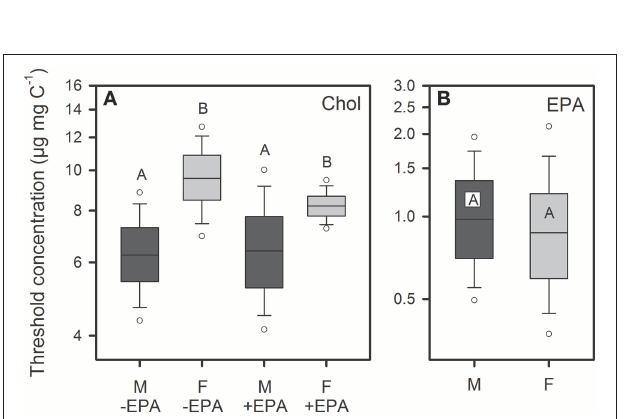
FIGURE 2 | Dietary threshold concentrations (defined as 25% reduction of g ∞ ) for sterol- and EPA-limited juvenile somatic growth of female (F) and male (M) D. magna. Juveniles were raised either on a dietary cholesterol gradient, in the absence and presence of saturating amount of dietary EPA (A) , or on a dietary EPA gradient in presence of saturating amounts of cholesterol (B) . Data are presented as medians, quartiles ( box ), 10 and 90% percentiles ( whiskers ), and 95% confidence intervals ( circles ). Data labeled with the same letters are not significantly different ( A , sex: P < 0.01, EPA supplementation: P = 0.73, sex × EPA: P = 0.71; B , sex: P = 0.74).